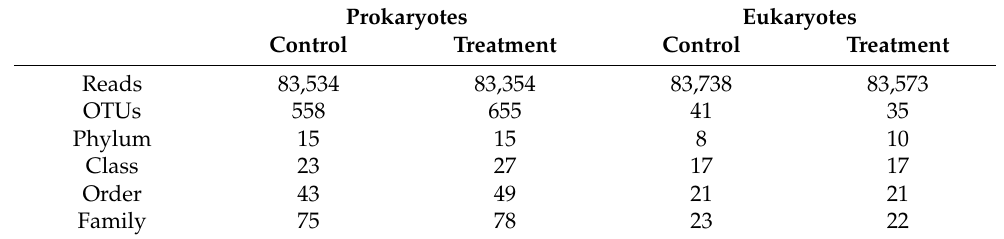
Table 1. Summary of sequencing results at different taxonomical levels of prokaryotic and eukaryotic microbiota in the control and treatment groups.